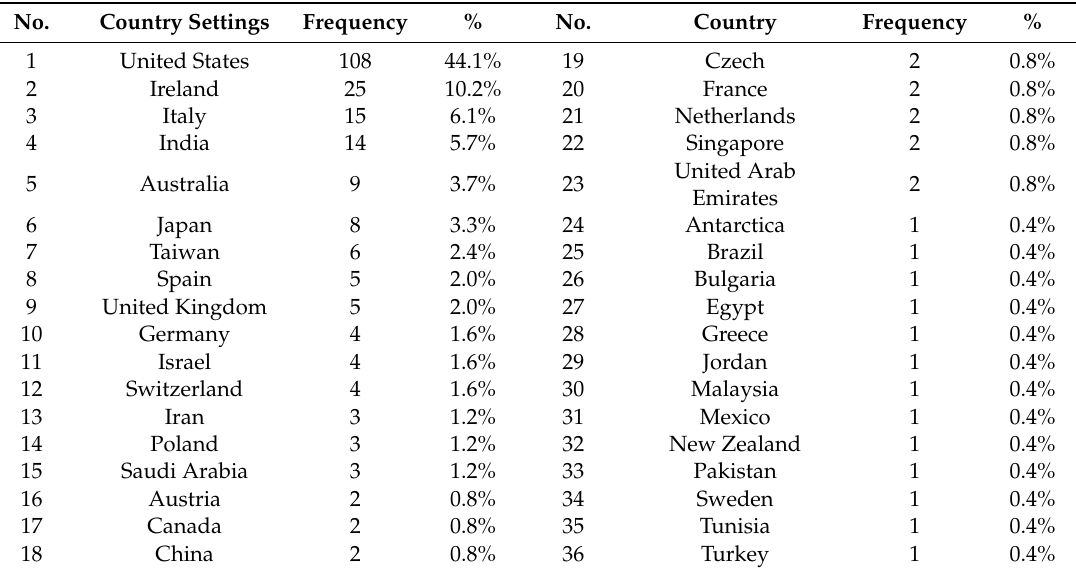
Table 3. Number of papers by countries as study